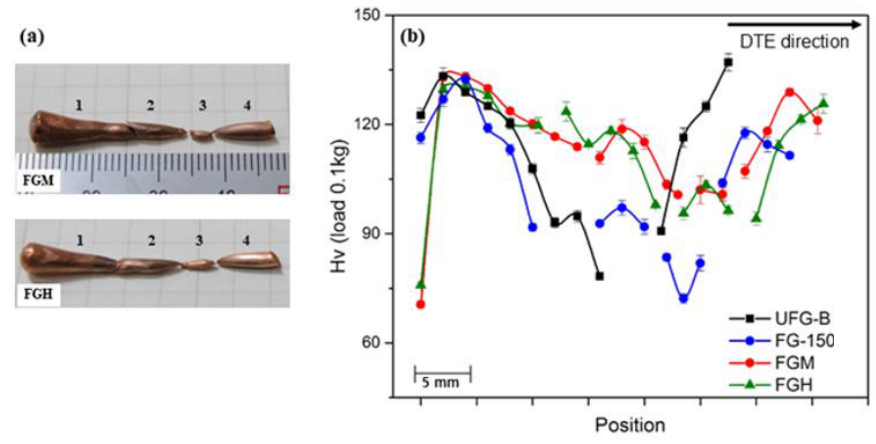
Figure 5. ( a ) Soft-recovered DTE fragments of the FGM and FGH Cu specimens in the order they exited the die. Conical fragments indicated by “number 1” are the remnants that remained in the DTE die. ( b ) Micro-Vickers hardness profiles of the fragments along the DTE direction. The numbers match the fragment numbers in ( a ) (UFG-B [9], FG-150 [9]).